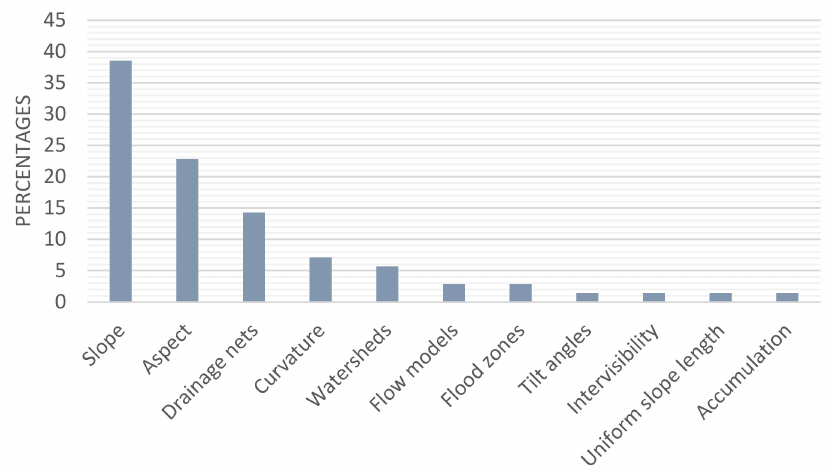
Figure 11. Distribution of the parameters used in the quality evaluation in di ff erent